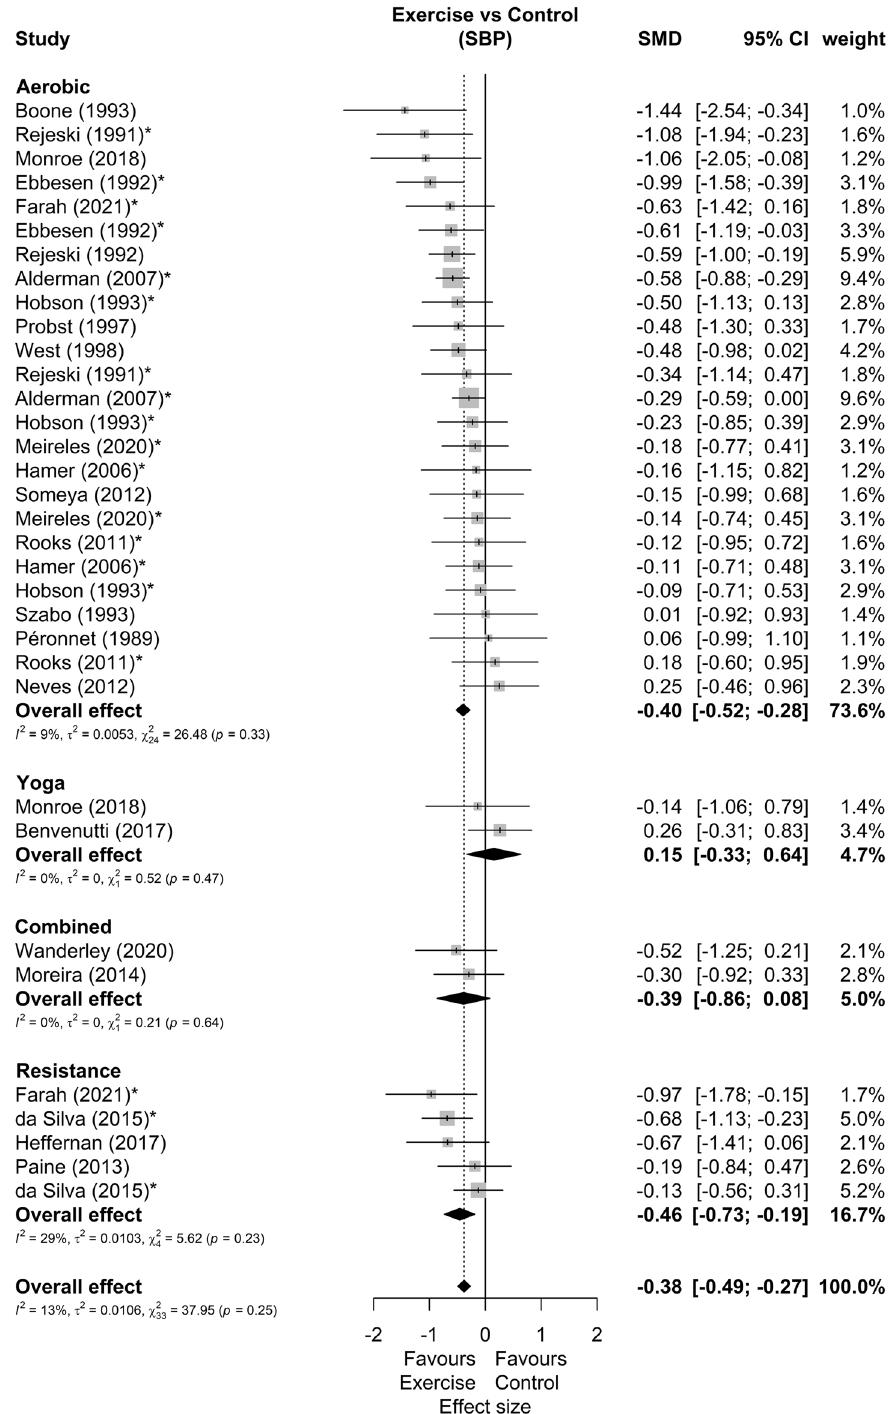
Figure 2. Systolic blood pressure reactivity forest plot. SMD, standardized mean difference; SBP, systolic blood pressure; CI, confidence interval; *, studies with multiple